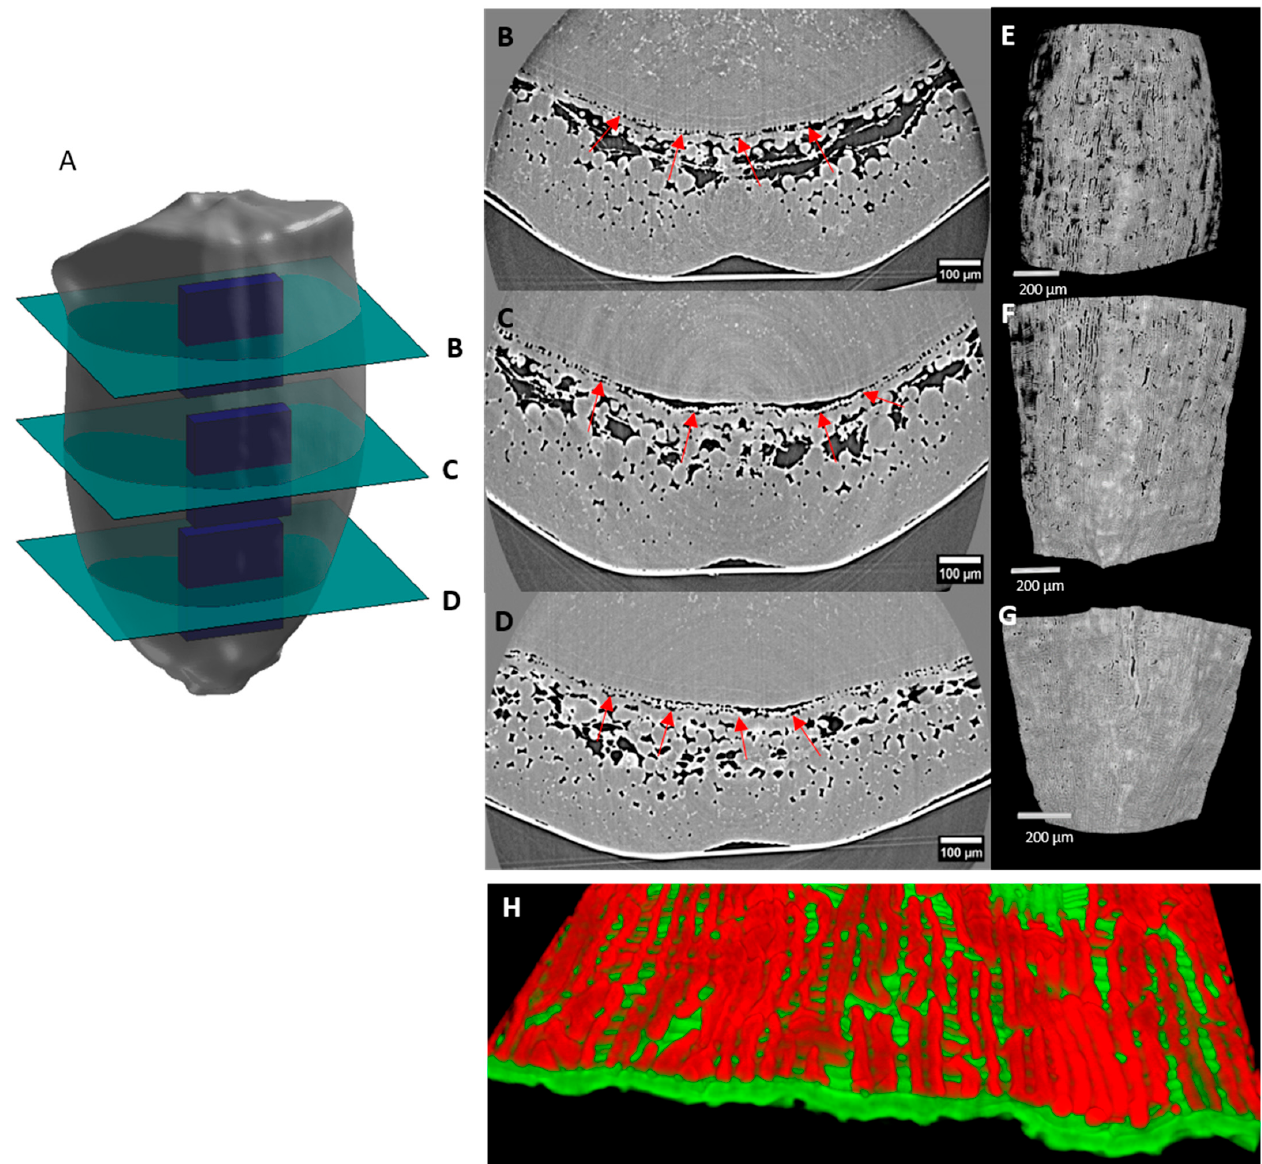
Figure 11. Longitudinal variability of the tube cells within the dorsal part of caryopses at 150 ◦ DAA at different Z-positions. ( A ) Localization of the regions of interest: top ( B , E ), middle ( C , F ), bottom ( D , G ), using high-resolution tomography images. Red arrows on virtual X-Y sections ( B – D ) indicate the tube cells. ( E – G ) A 2D projection of a 3D visualization of the grid formed by the tube cells. ( H ) Example of superimposition of cross cells (green layer) and tube cells (red layer) in the dorsal × middle part of the wheat